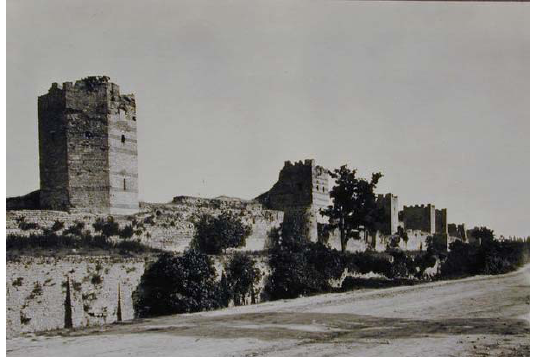
Figure-2 20. Century photograph of the Byzantine Land